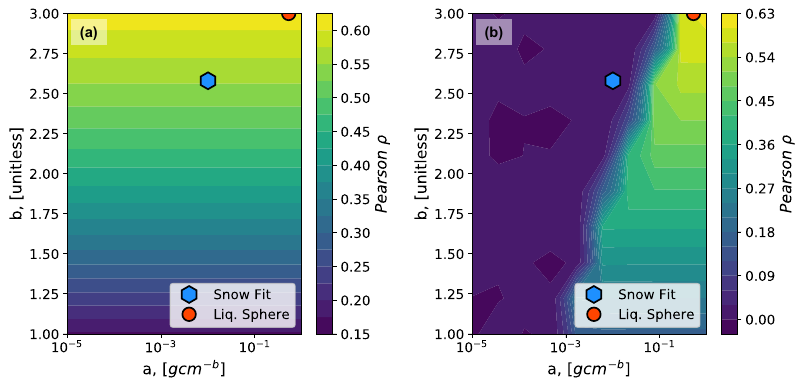
Figure 8. Investigating the variance of the correlation between R and D m with various a and b values in the calculation of mass ( m ( D ) = aD b ). ( a ) No variability in Equation (28) is used. The hexagon is the fit a and b values to the entirety of the Finland snowfall data, while the circle is the values for a liquid sphere. ( b ) Same as ( a ), but now the mass is randomly sampled from a normal distribution with the mean predicted by Equation (28) and the standard deviation given from the observations shown in Figure